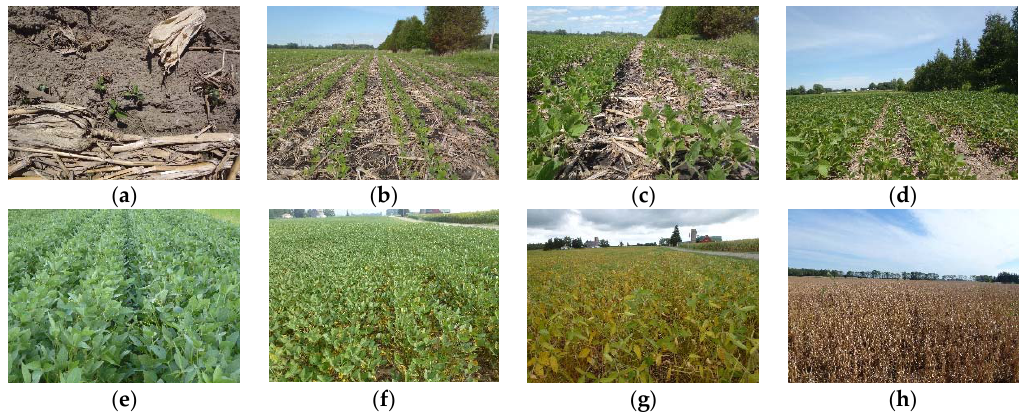
Figure 10. The ground truth photos of soybean. ( a ) May 23, ( b ) June 19, ( c ) July 2, ( d ) July 16, ( e ) August 11, ( f ) September 3, ( g ) September 13 and ( h ) September 25.